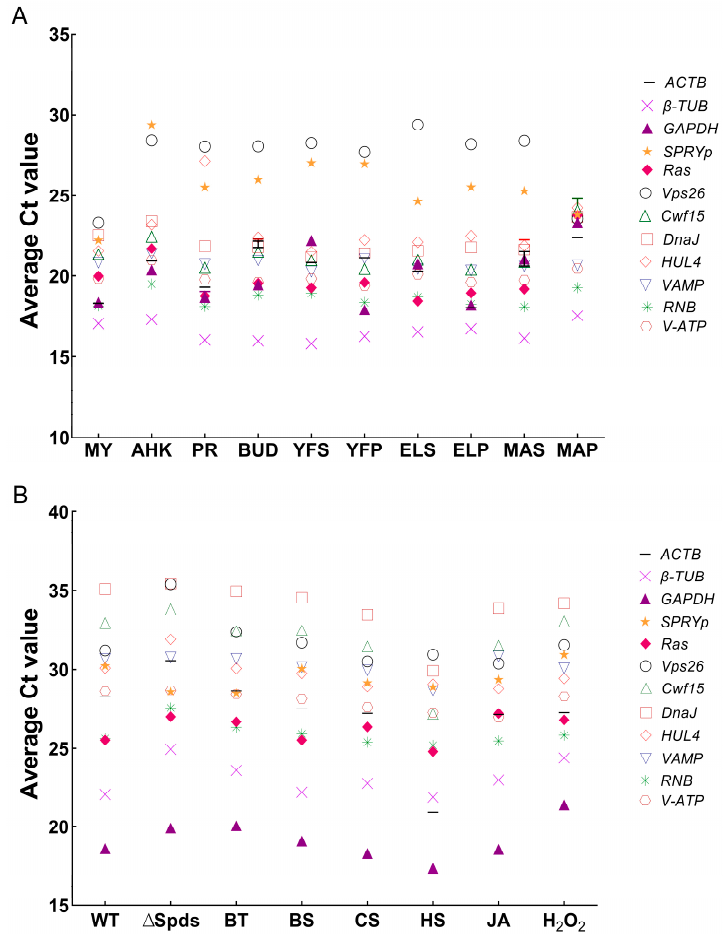
Figure 2. RT-qPCR Ct value of 12 ICGs in different samples of F. filiformis and N. crassa . ( A ) Average Ct value of three biological replicates and three technical replicates were shown on the Y-axis. The 10 samples of different developmental stages in F. filiformis were shown on the X-axis: mycelia, aerial hyphal knot; primordia, bud, pileus in the young fruiting body, stipe in the young fruiting body, pileus in elongation stage, stipe in elongation stage, pileus in maturation stage and stipe in matura- tion stage. ( B ) Average Ct value of three biological replicates and three technical replicates were shown on the Y-axis. The eight samples of different treatment conditions in N. crassa were shown on the X-axis: WT, ∆ Spds, BT, BS, CS, HS, JA, and H 2 O 2 . The stability of the 12 ICGs candidates was evaluated based on RT-qPCR Ct values using 2 professional statistical algorithms: geNorm and NormFinder. Firstly, the gene ex-